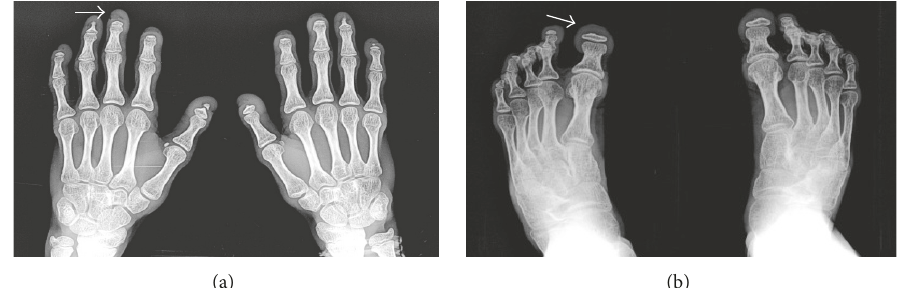
Figure 4: Anteroposterior radiograph of both hands (a) and foot (b) showed resorption of terminal phalanges with preservation of soft tissue (white